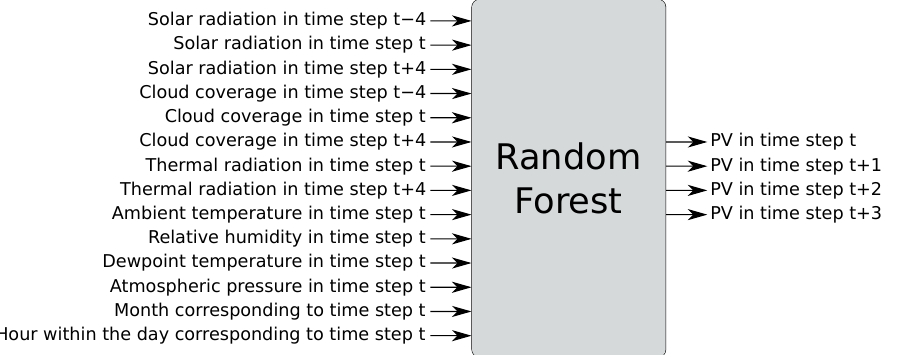
Figure 4. Illustration of the PV prediction